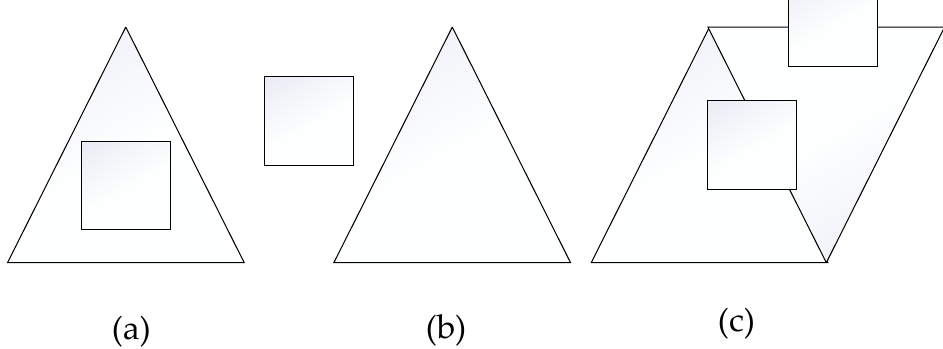
Figure 1. The schematic diagram of attribute information judgment of sound ray tube bundle. ( a ) valid ray tube; ( b ) invalid ray tube; ( c ) divergent ray tube.